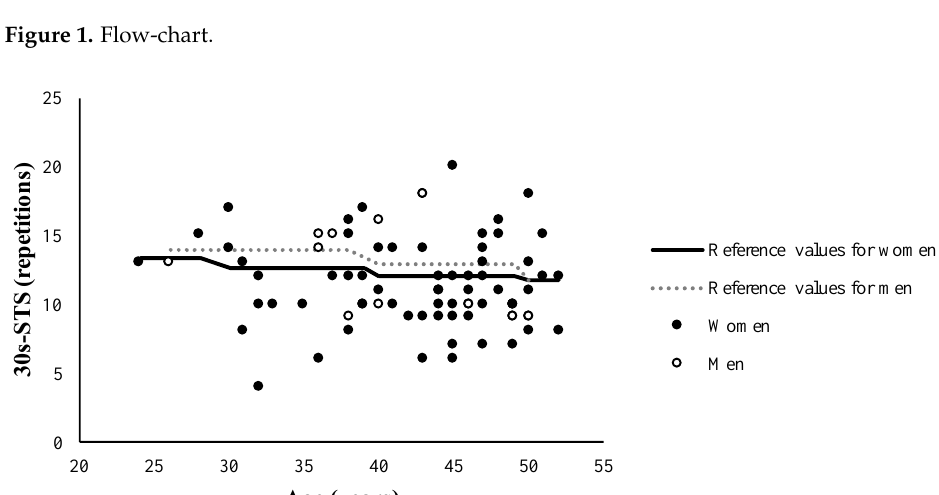
Figure 1. Flow-chart. The median age was 44 (range: 24 – 52) years, and 68 (86.1%) participants were women. Time passed after COVID-19 infection ranged from 2 to 28 months, with a median of 17 months. In the total sample, 72.2% of cases had moderate to extreme pain, with high levels of dyspnea and fatigue (Table 1).